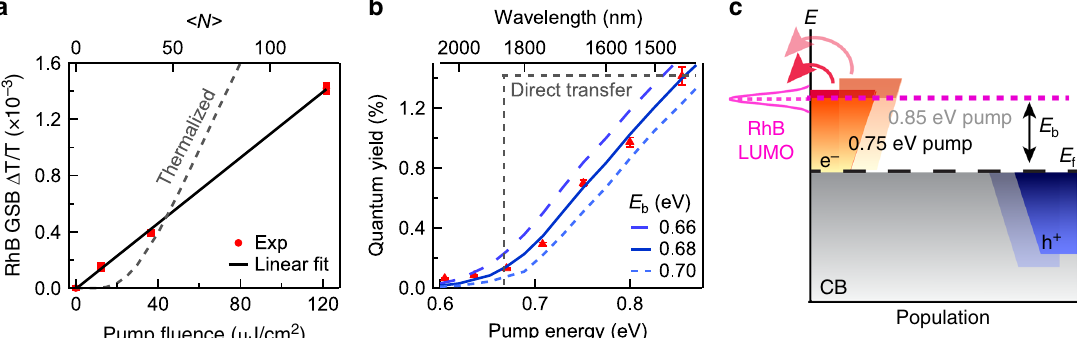
Fig. 4 Mechanistic study of hot-electron transfer. a RhB ground state bleach (GSB) signal (red symbols) as a function of pump fl uence or averaged photon number per NC (< N >) and the linear fi t (black line). Also shown in gray dashed line is modeled hot-electron transfer behavior with thermalized electron distribution, showing superliner behavior. b PIHET quantum yield (QY) as a function of pump photon energy. The red triangles are experimental results. The blue dashed line is modeled results with different barrier height E b and transfer ef fi ciency η of 5.5%. The gray dashed line shows the direct transfer behavior, contradicting with experimental results. c Scheme of hot-electron transfer with two pump energies (0.75 and 0.85 eV) after Landau damping before electron thermalization. The gray region shows the undisturbed fi lled states in conduction band. The orange and blue regions represent the excited electrons and empty states left, respectively, after Landau damping under different pump photon energies. Higher pump energy leads to more electrons above barrier